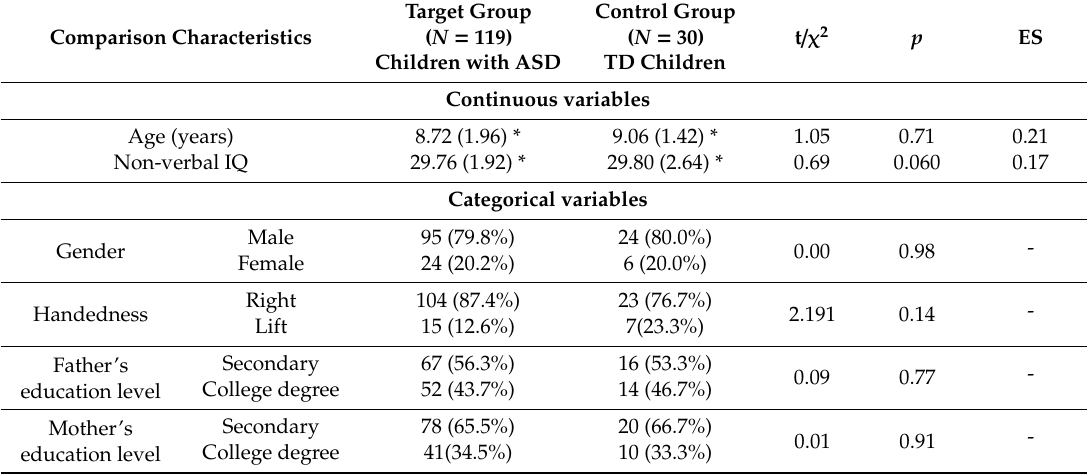
Table 1. Demographic and Clinical Characteristics of the